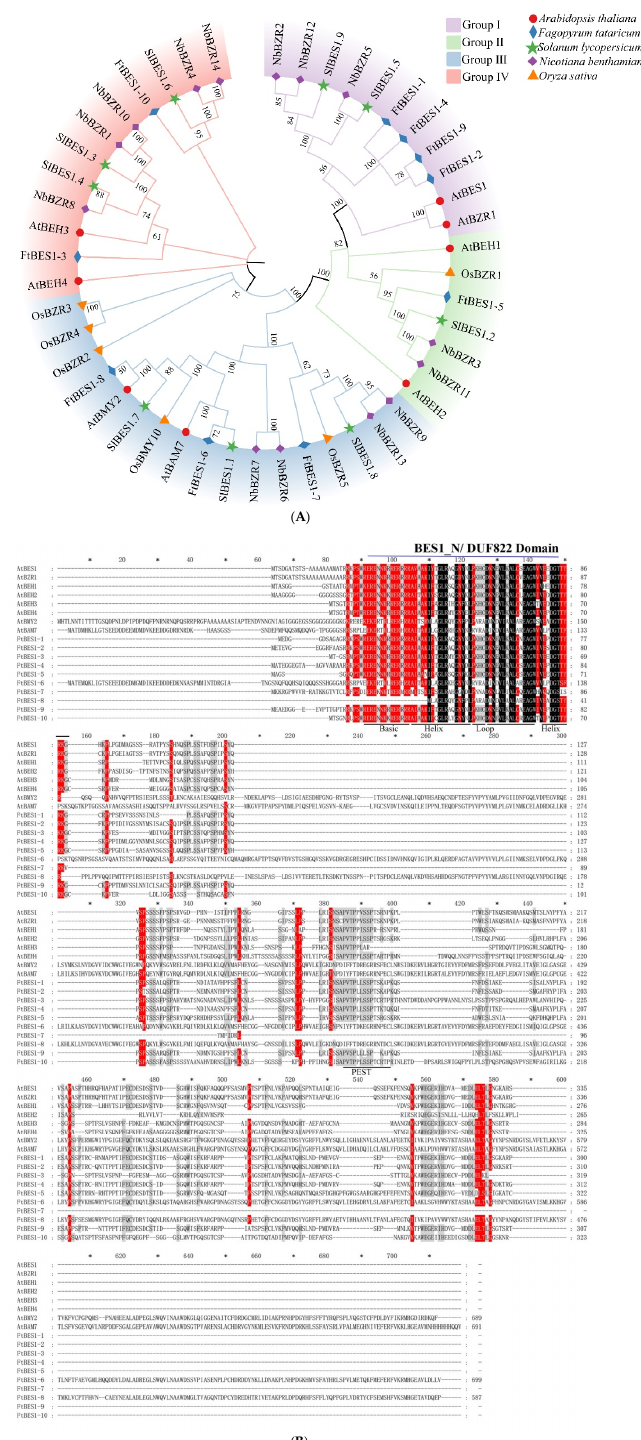
Figure 1. ( A ) Phylogenetic trees of the BES1 genes of Tartary buckwheat, Arabidopsis , tomato, tobacco, and rice. Neighbor joining evolutionary trees with 1000 replicate values were constructed using MEGA7.0 and embellished using the online tool Chiplot. BES1 gene family members were divided into four categories and represented using different colors, and BES1 gene members of different species were distinguished using different icons. ( B ) Multiple sequence alignment of BES1 proteins in Tartary buckwheat and Arabidopsis. The blue line represents N-terminal DUF822. The black line represents basic-helix1-loop-helix2 (bHLH) and PEST domain. * Indicates an interval of 10 amino